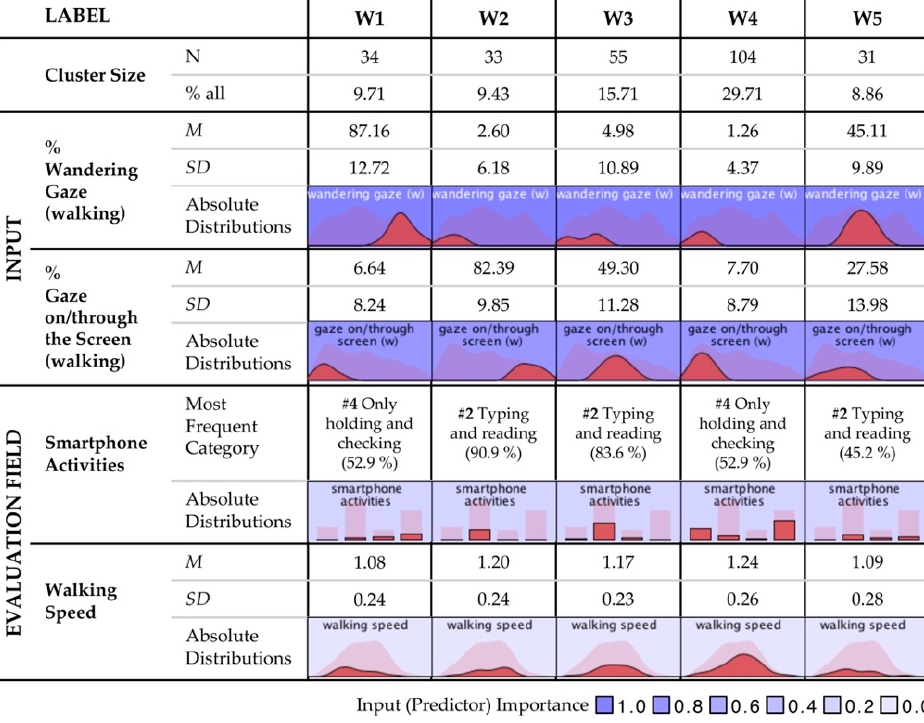
Figure 7. Results of centroids for the smartphone users who walked without stopping (n = 257). Absolute distribution graphics were generated with SPSS (v25.0).